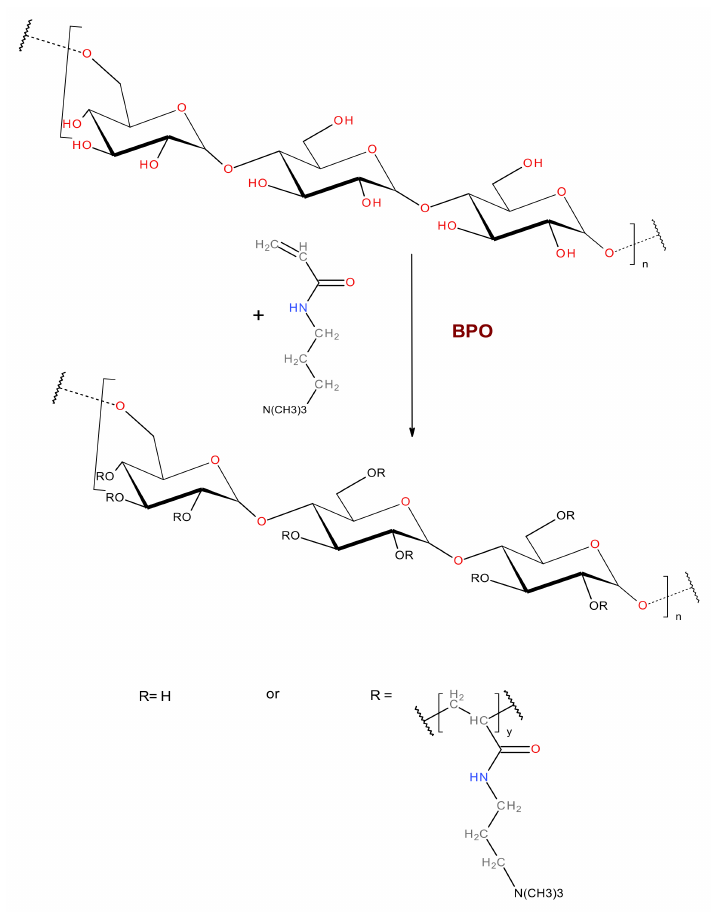
Figure 1. General synthetic scheme for cationic derivative of pullulan